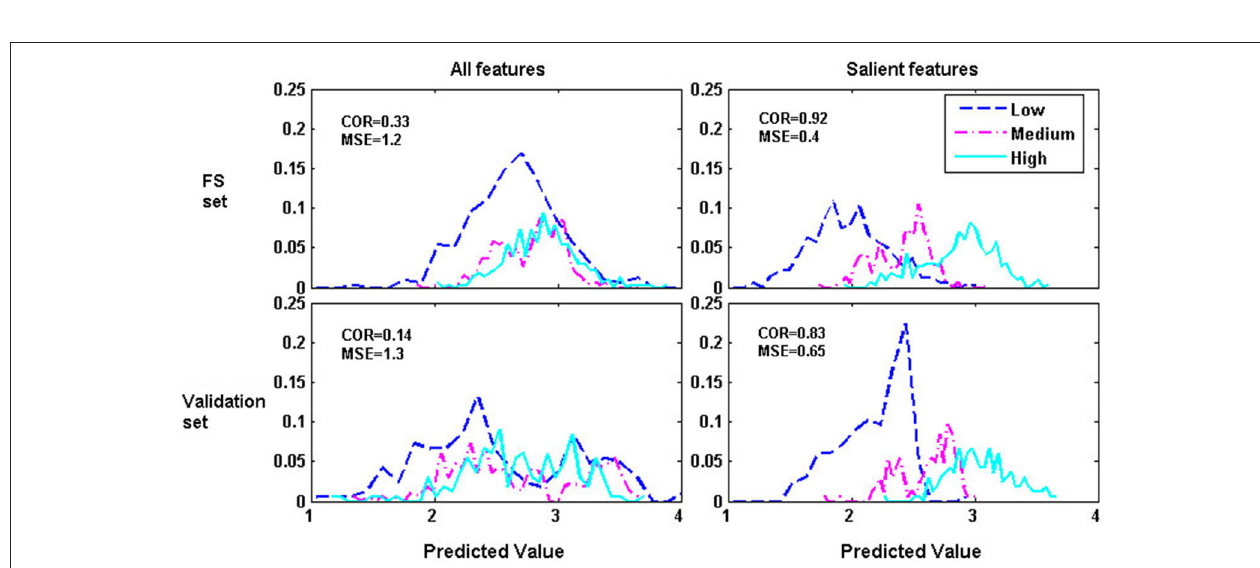
FIGURE 4 | Illustrations of the distribution curves of model predicted values for FS and validation data with AF and SF respectively under NM cross-task condition for one subject .